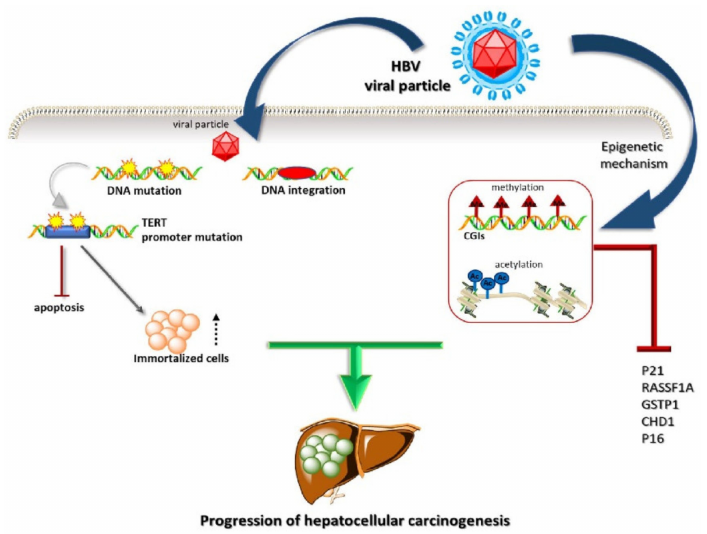
Figure 2. HBV liver cell infection: through integration into cell DNA, HBV changes gene expression of relevant genes and among them